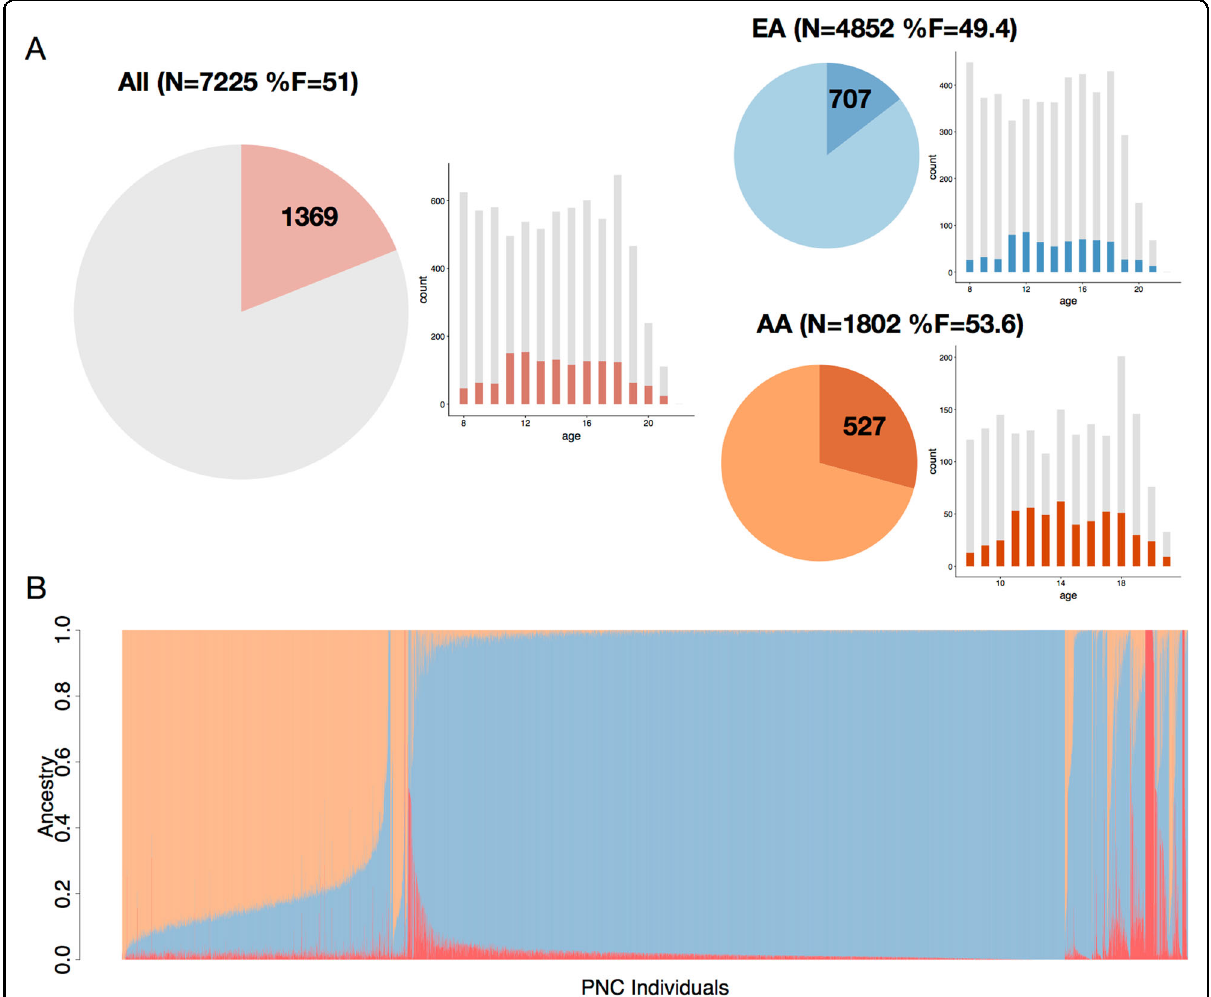
Fig. 1 Demographics of the PNC cohort. A Demographic overview of all subjects included in our analyses: pie charts display the proportion of subjects with psychosis spectrum symptoms (PS), and histograms the age distributions, with darker colours indicating PS subjects. Three groups included are all subjects (All), subjects of European and African American ancestry (EA and AA respectively). B Relative admixture ancestry components (based on K = 3) for the PNC cohort, ordered by self-reported